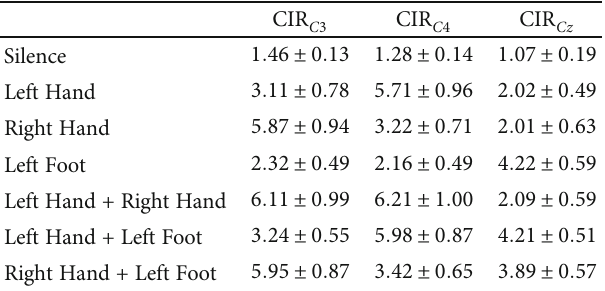
Table 2: Mean and standard deviation of CIRs in seven mental